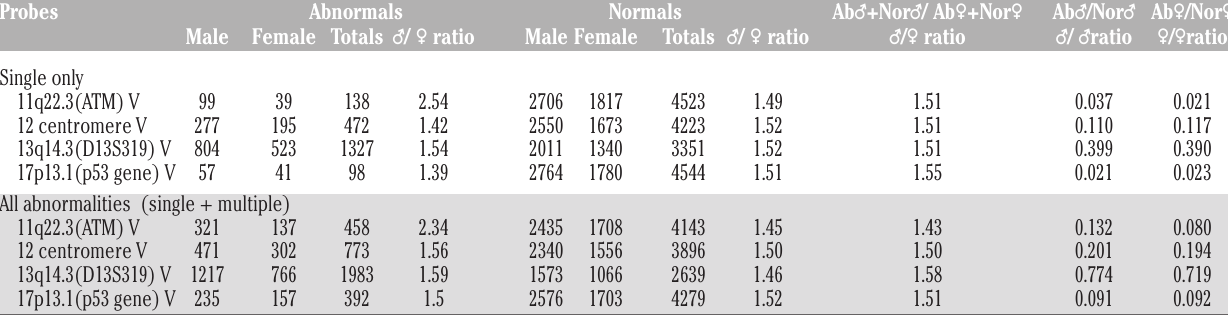
Table 3. Male-to-female sex ratio for fluorescence in situ hybridization (FISH) abnormalities, FISH normal results and total FISH tests for each of the probes used to evaluate the chronic lymphocytic leukemia study population. Probes Abnormals Normals